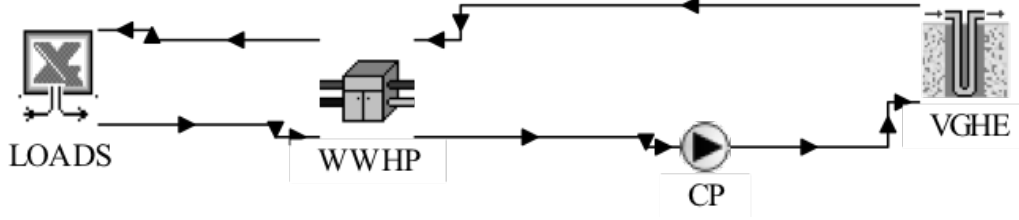
Figure 12. TRNSYS model scheme used to simulate the ground heat